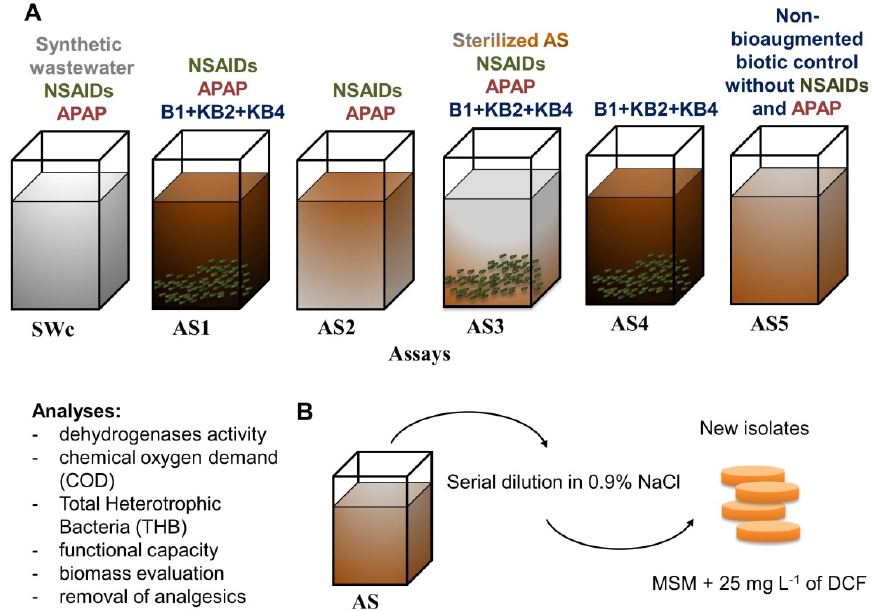
Figure 1. Scheme of the experimental set-up. ( A ) Different non- or bioaugmented assays AS1–AS4 fed with NSAIDs and APAP and control assay AS5, ( B ) scheme of the isolation of new DCF-degrading strains from the DCF-treated AS by classical enrichment technique. NSAIDs—non-steroidal anti-inflammatory drugs (IBU, NPX, and DCF); IBU—ibuprofen, NPX—naproxen, DCF—diclofenac, APAP—paracetamol.